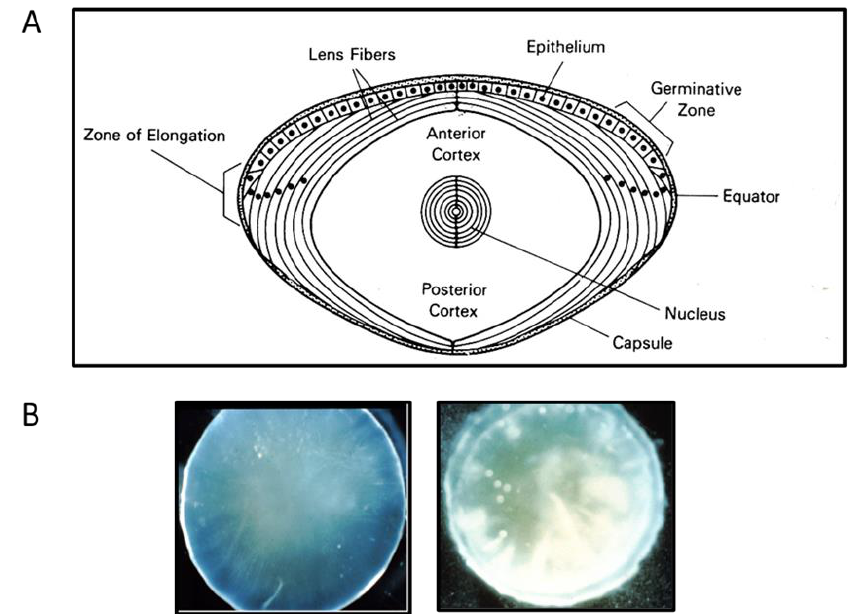
Figure 1. Schematic diagram and photos of a mammalian lens. A . Diagram depicts the capsule, epithelium layer, outer cortical (younger), inner cortical (older) fiber cells, and nucleus regions of a mammalian lens. B . Photos of a clear (left) and an opaque, cataractous (right) human lens.